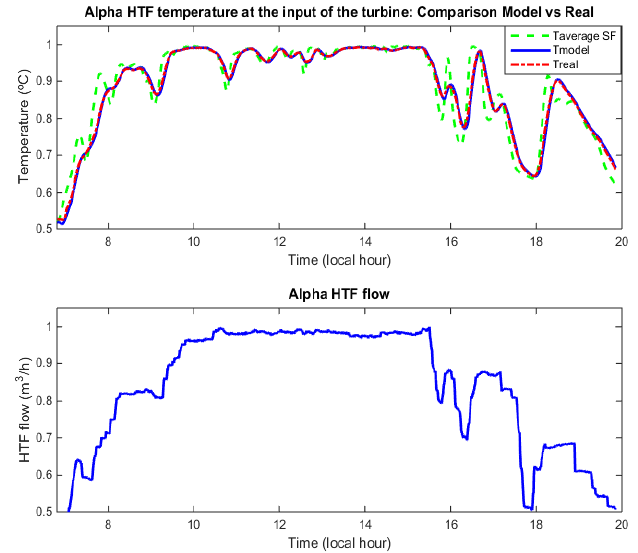
Figure 11. Mojave Alpha, HTF temperature at the input of the Steam generator: ( top ) model (solid blue) and real (red dash-dotted); and ( bottom ) HTF